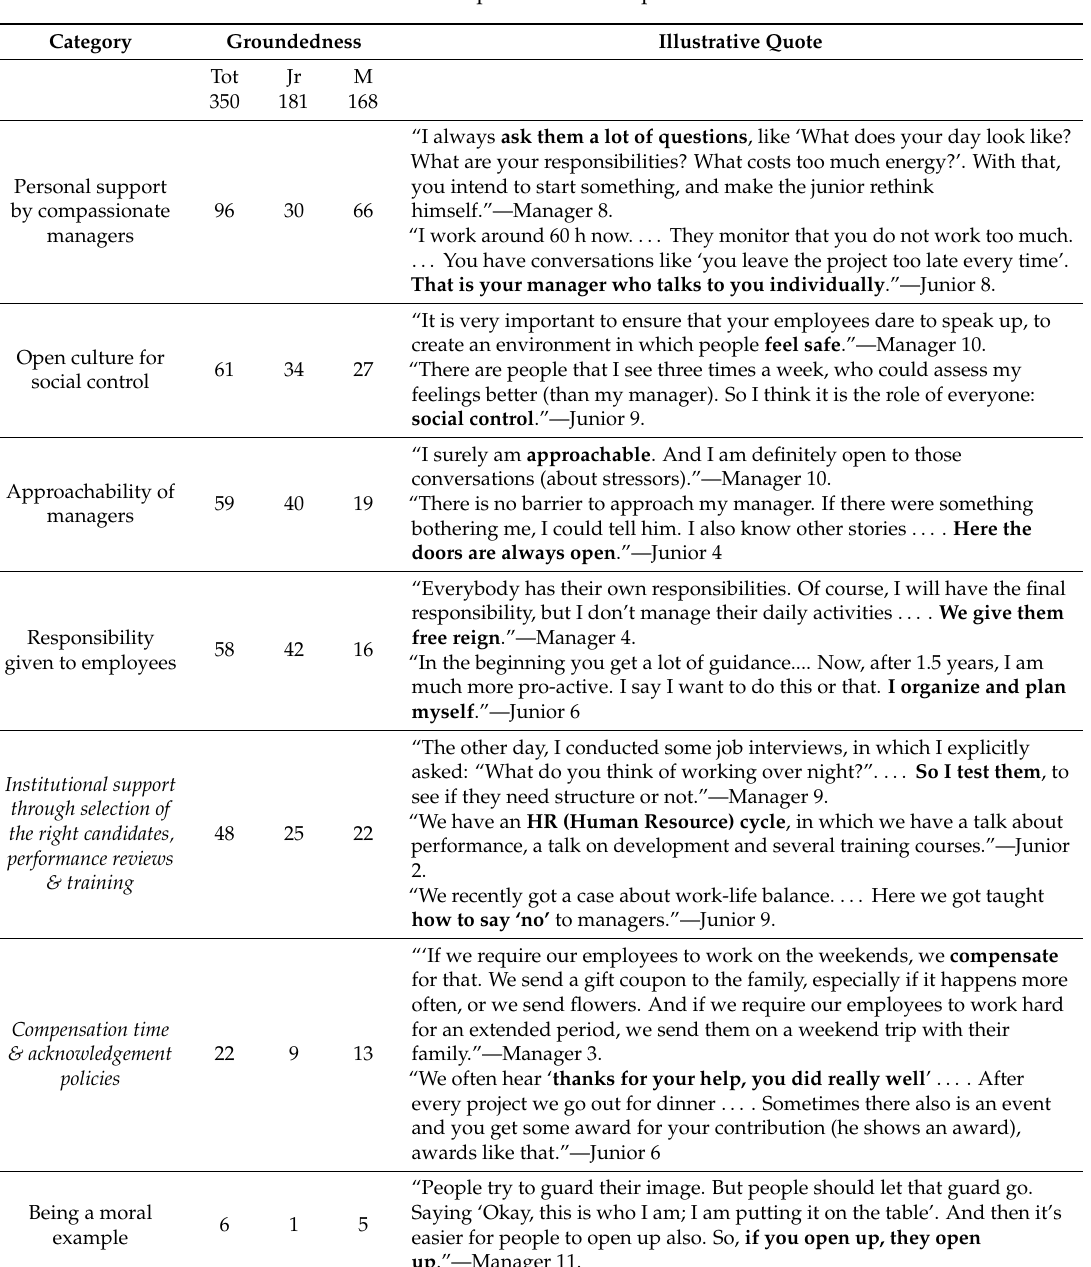
Table 7. Moral leadership tactics used to prevent moral